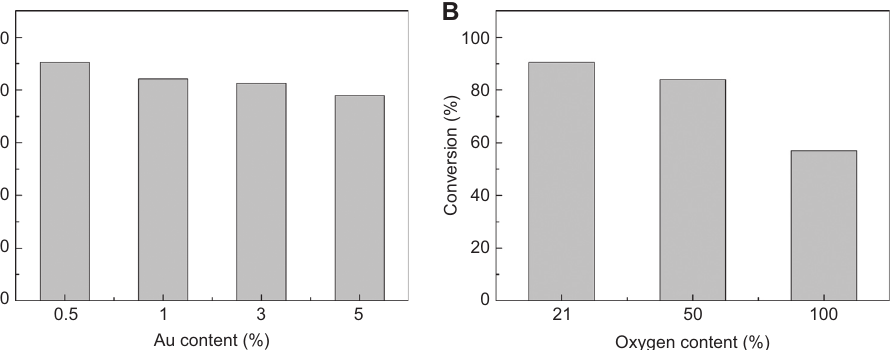
Figure 6 Oxidation of benzyl alcohol in a PTFE capillary. (A) Influence of the Au content of the nanoparticles on the benzyl alcohol conversion. (B) Influence of the molar oxygen/alcohol ratio on the benzyl alcohol conversion for 0.5% Au/Pd NP: 1/1 (21%); 2.9/1 (50%); 4.7/1 (100%). Reaction conditions: 50 ° C, 20 m capillary length, 1000- μ m ID, 0.4 ml/min overall liquid flow rate, 4.25 ml/min air/gas flow rate, τ = 15 min.